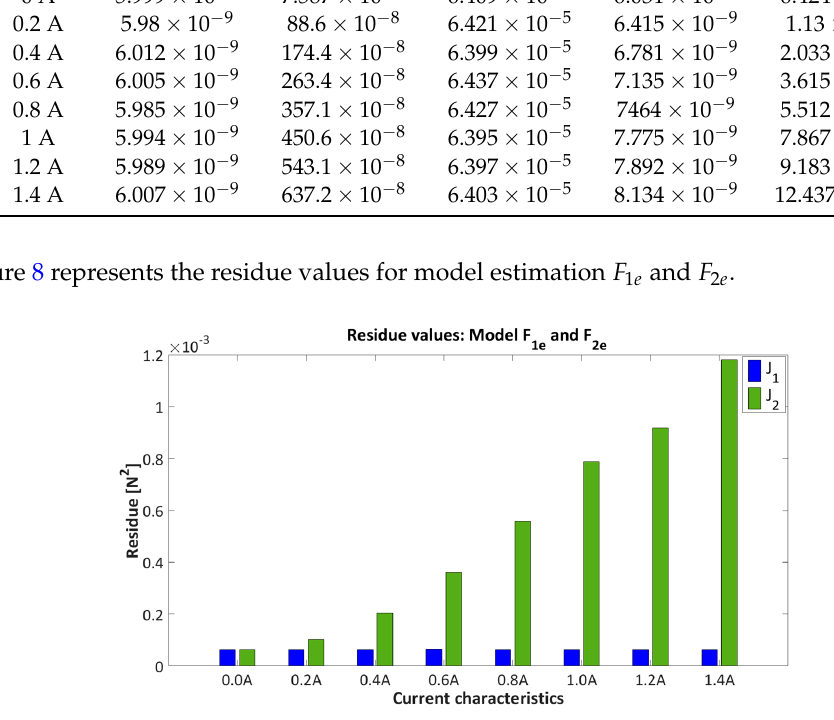
Table 3. Parameter estimation of the model (cid:1832) (cid:2869)(cid:3032) and (cid:1832) (cid:2870)(cid:3032) , by current characteristics 0 A–1.4 A .